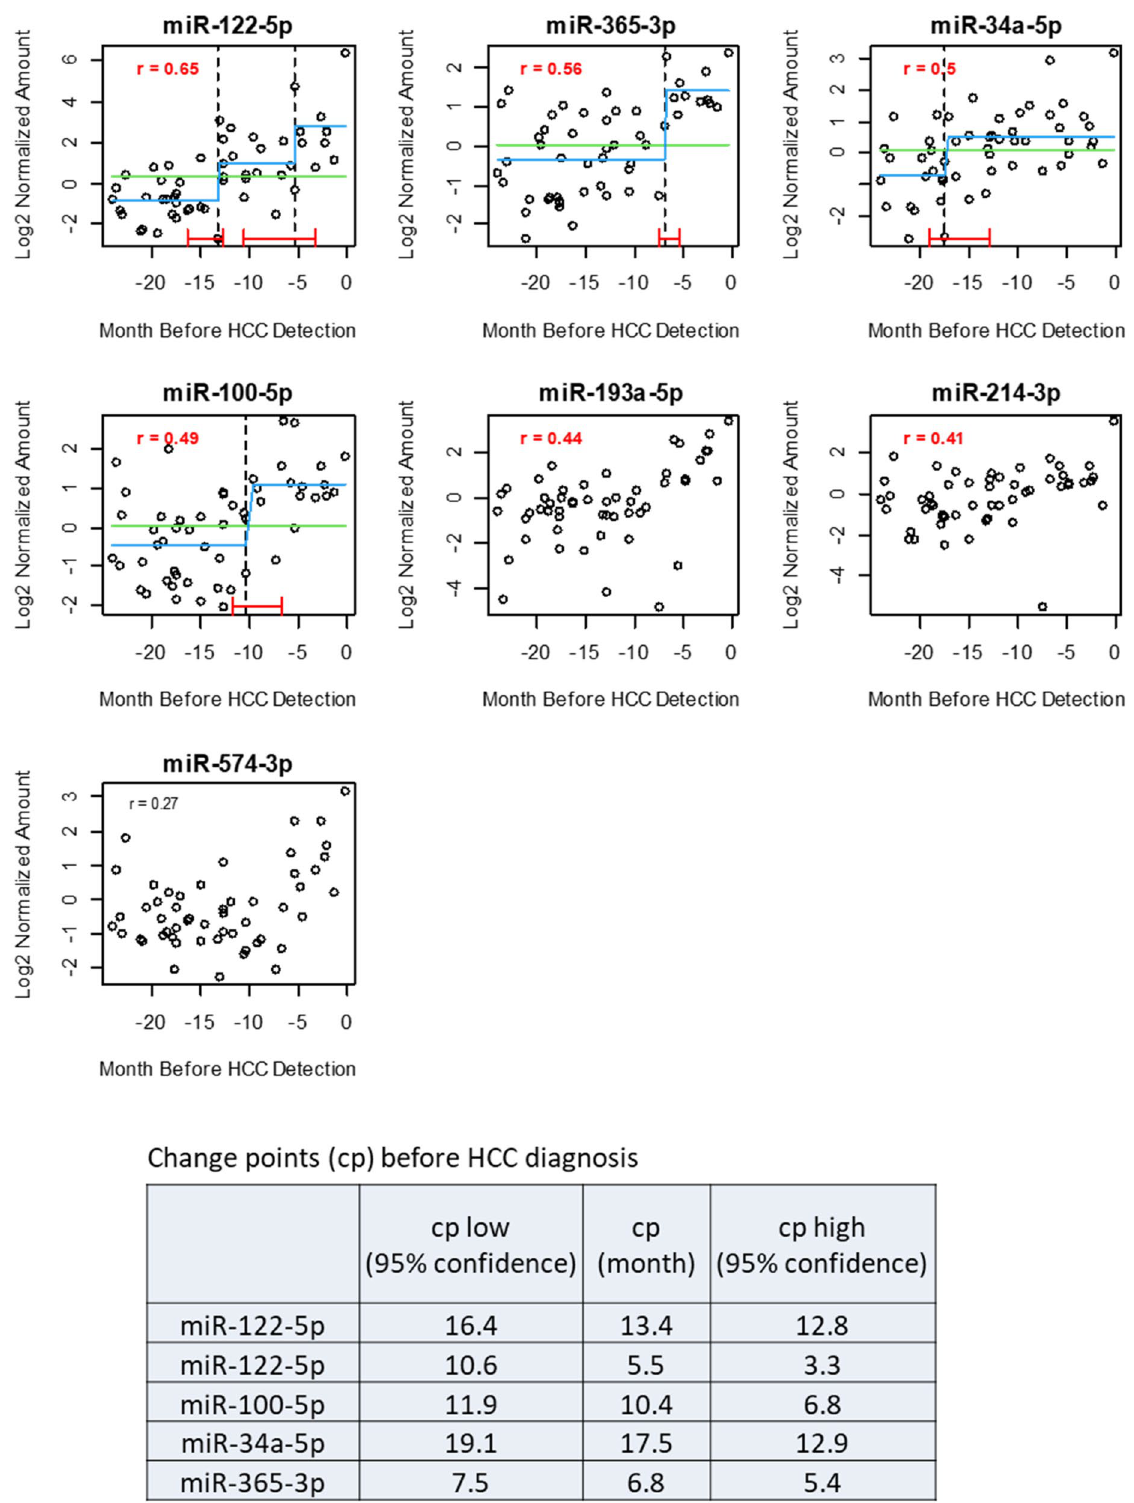
Figure 5. Change point analysis using the time-series data from the mouse orthologs of the 4 human circulating miRNA markers. Plasma levels for the circulating miRNAs in the F2 mice were plotted against the number of days counted backwards from HCC detection. r: correlation coefficient between y and x axes. Dash line: the identified change points with statistical significance (p < 0.05). Red line: 95% confidence interval for each change point detection. Blue line: fitted line of the regression model. Green line: fitted line of the null